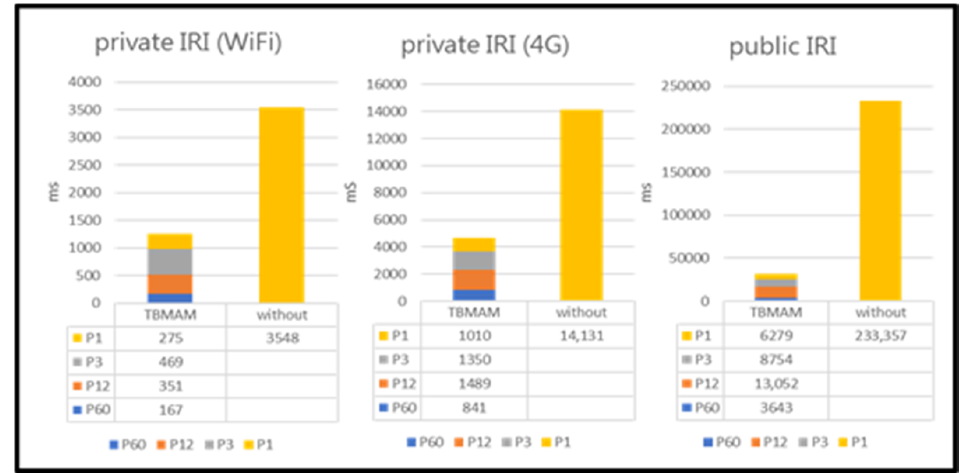
Figure 16. Cost of tree-based MAM (TBMAM) indexing.